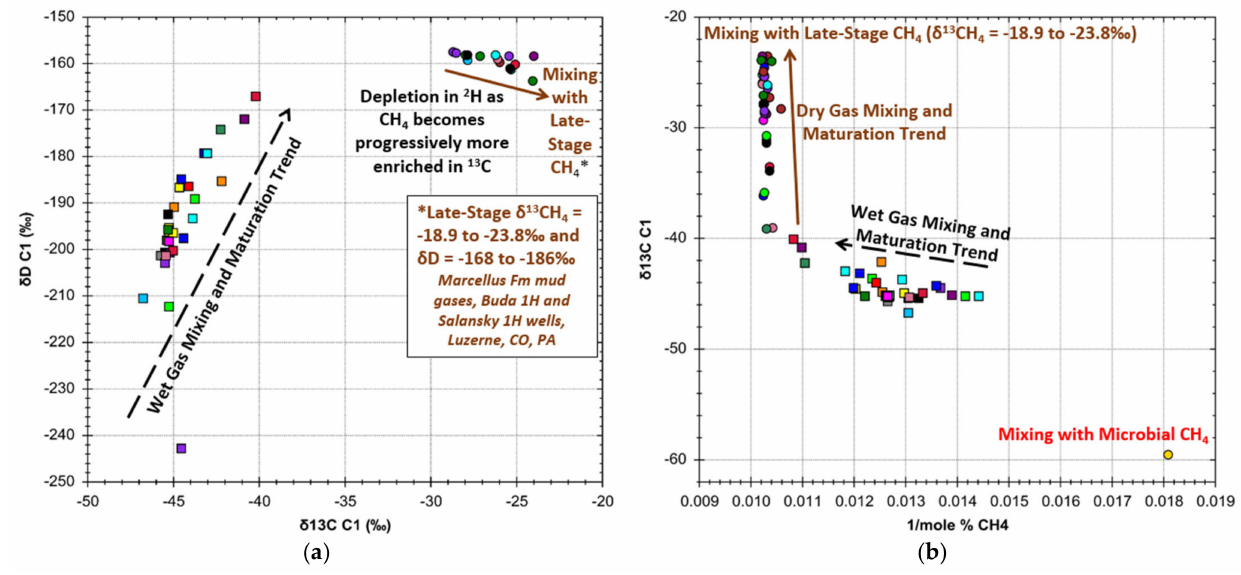
Figure 20. ( a ) Schoell plot [36] of δ 13 C versus δ D for methane in Marcellus Formation wet and dry gas samples from the Appalachian basin. Isotope compositions fall on two distinct trends. The wet gases (squares) plot along a mixing trend (R 2 = 0.7) showing progressive enrichment in 13 C and 2 H characteristic of a thermal maturation sequence [36]. The dry gases (circles) show depletion in 2 H as methane becomes progressively more enriched in 13 C (R 2 = 0.67). The extension of this trend to Late- Stage δ 13 CH 4 is discussed in the text. These two trends are identical to those published by Burruss and Laughrey [72] for Ordovician and Silurian gases produced from conventional and unconventional reservoirs in the basin. ( b ) Variation of methane isotopic composition with concentration in Marcellus Formation wet and dry gas samples. The wet gases fall along the maturation/mixing trend on the Schoell plot in 20a and along the Rayleigh fractionation trend for hydrocarbons generated by oil cracking shown in Figure 19b. The dry gases show a mixing trend consistent with the trend shown on the Schoell plot (20a) that extends to the Late-Stage CH 4 end member. These trends are also identical to those exhibited by wet and dry Ordovician and Silurian gases produced in the basin